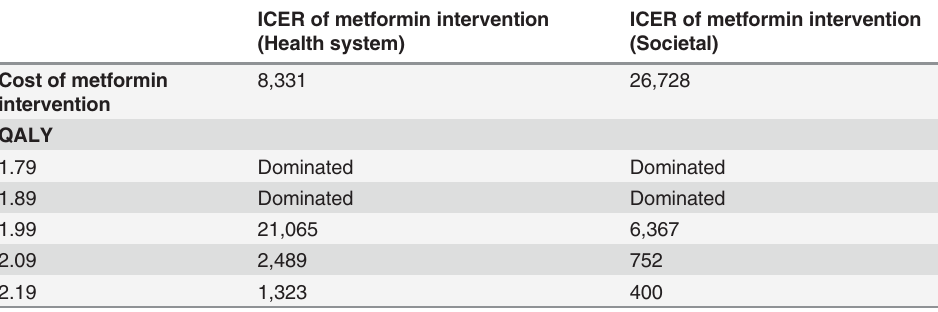
Table 6. One-way sensitivity analysis of metformin intervention ’ s effectiveness ICER of metformin intervention (Health system)